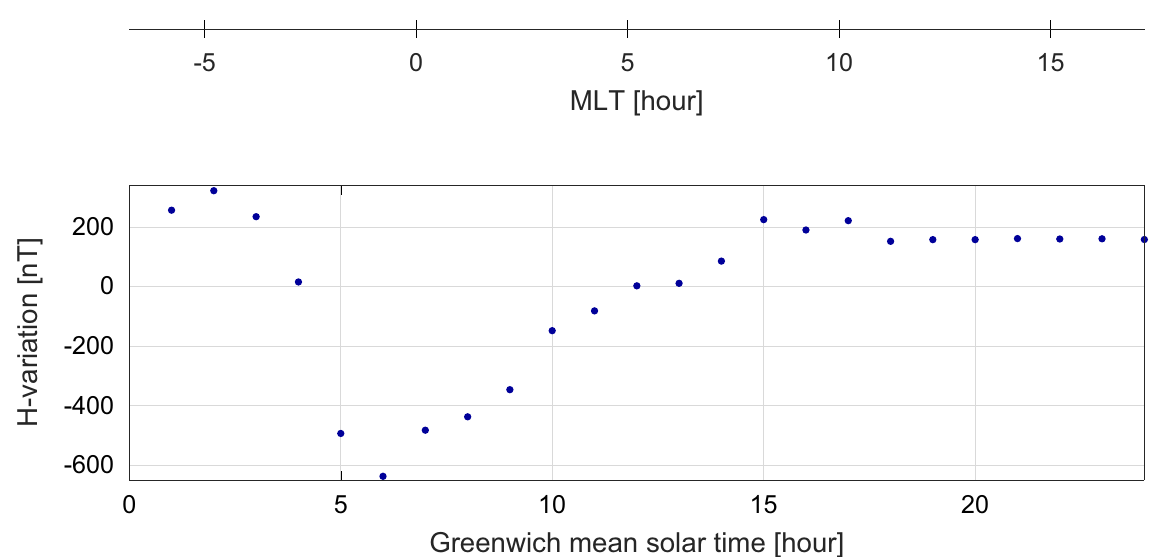
Fig. 2. The pro fi le of the variations of the horizontal intensity during the magnetic storm of 4 February 1872 that was recorded by the low-latitude observatory Colaba (Bombay), India. The displayed values are 1-hour means. The additional time axis at the top of the fi gure shows the magnetic local time